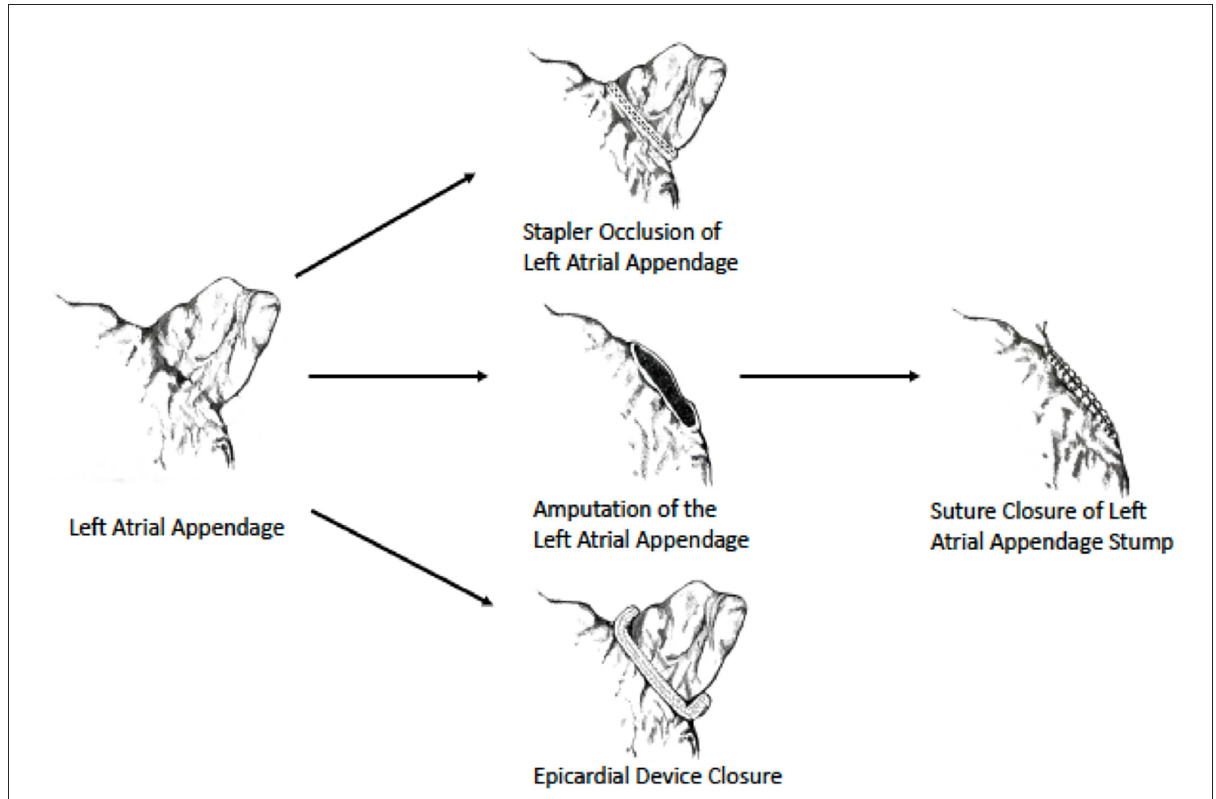
FIGURE1 Surgical LAA occlusion techniques used in LAAOS III trial. Image reprinted with permission from the New England Journal of Medicine (52).